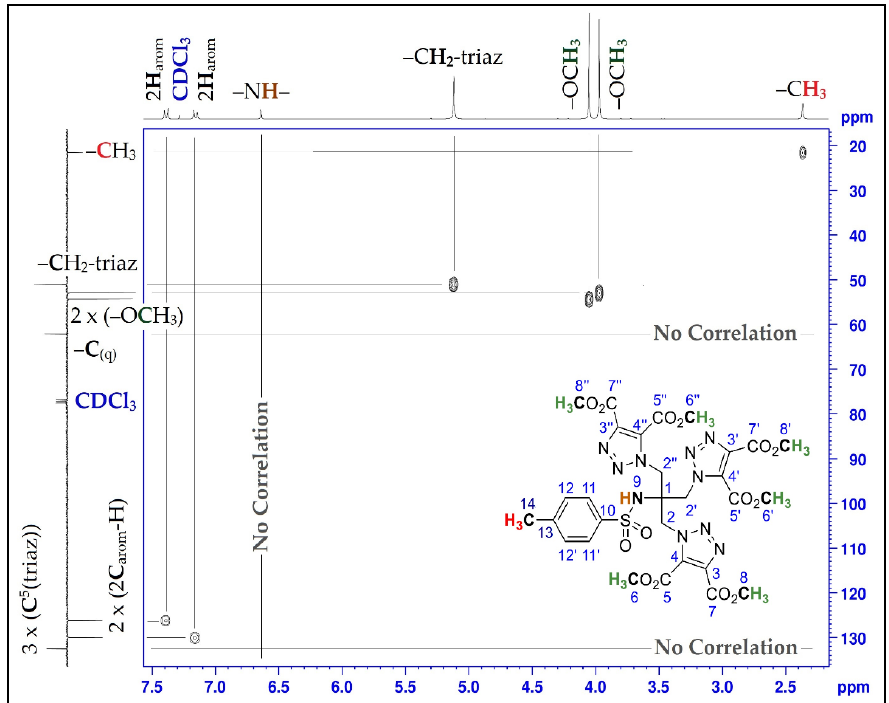
Figure 2. 2D HSQC spectrum of compound ( 3